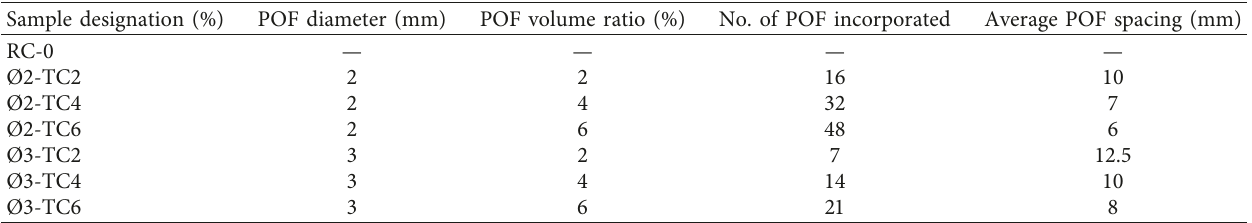
Table 4: Details of POF integrated on translucent concrete specimens for the compressive strength test.